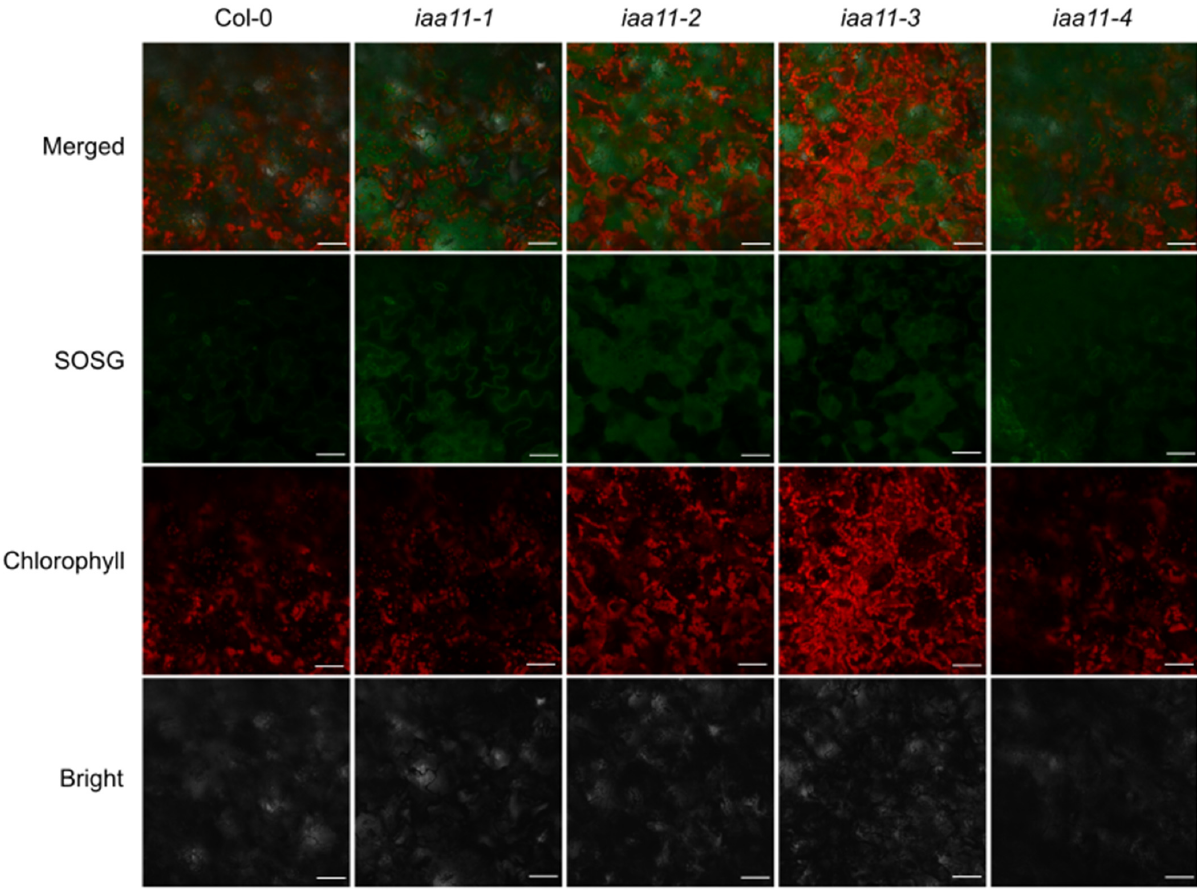
Figure 5. Visualization of singlet oxygen sensor green (SOSG). Images were taken 2 and 5 h after a 15 min treatment with 200 µ M DCMU and SOSG staining. Green and red colors represent SOSG and 15 min treatment with 200 µM DCMU and SOSG staining. Green and red colors represent SOSG chlorophyll fluorescence, respectively. White scale bars represent 50 µ and chlorophyll fluorescence, respectively. White scale bars represent 50 µm.